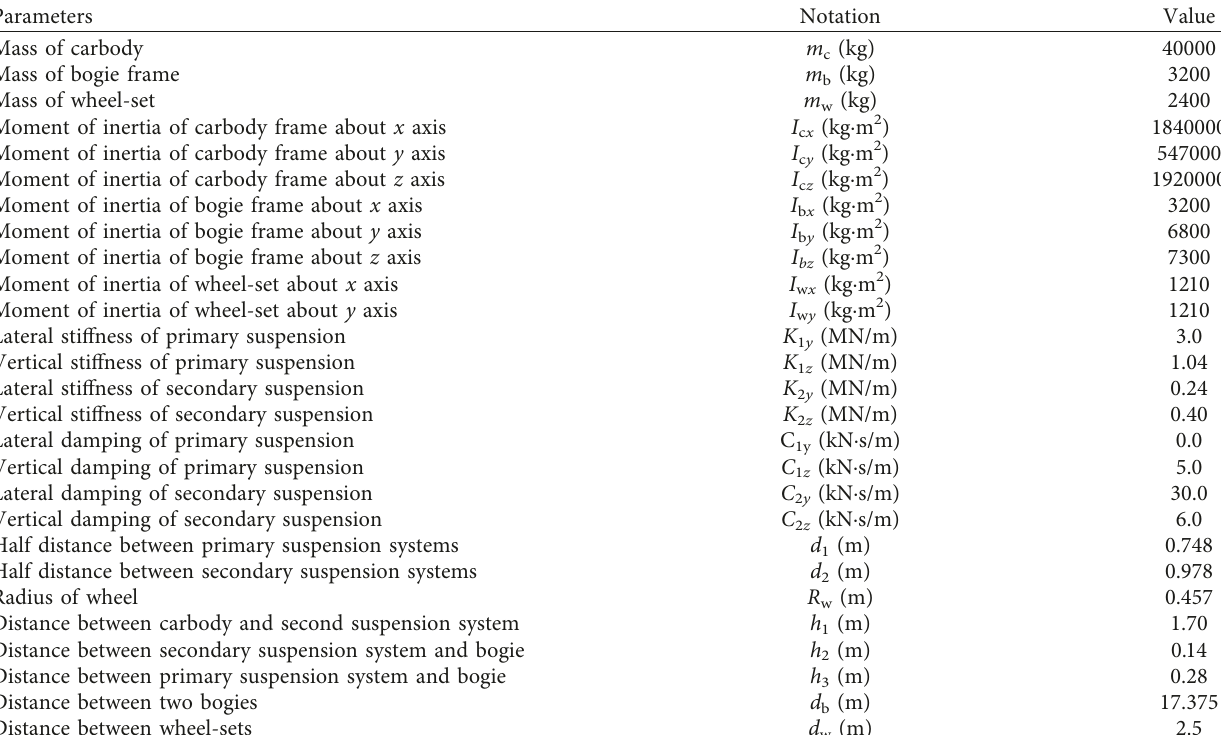
Figure 8: Schematic diagram of the VTSDM model. Table 1: Vehicle parameters.